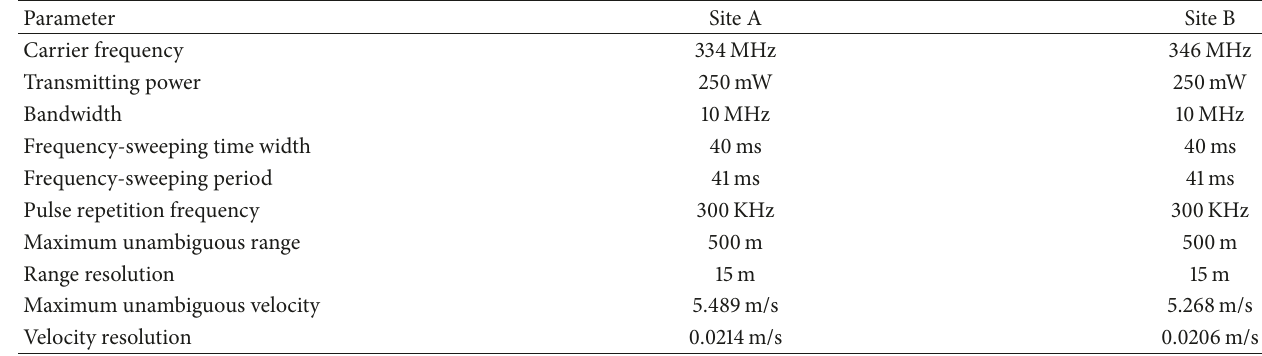
Table 2: OSMAR-SU waveform